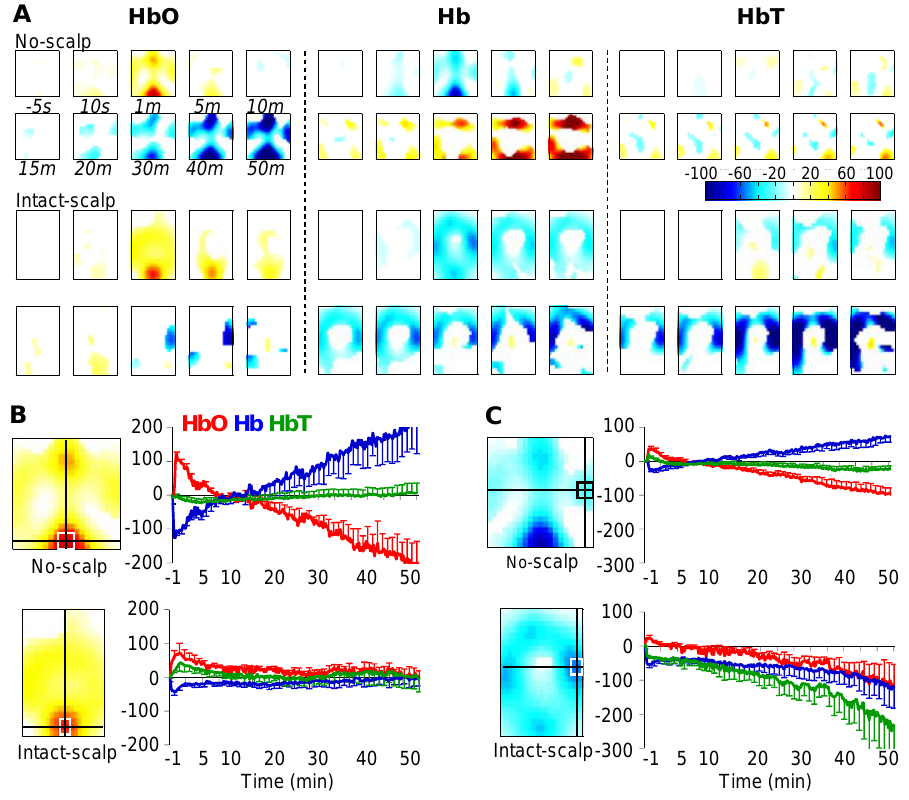
Figure 2. Formalin-induced hemodynamic changes in the no-scalp [12] and intact-scalp groups. ( A ) reconstructed images of hemodynamic changes at typical time points. The intensity of change (microMolar) is color-coded; only statistically significant changes (per pixel) are shown in color; ( B ) time series of hemodynamic changes at a middle posterior ROI (top: no-scalp [12]; bottom: intact-scalp). Locations of ROIs were determined in example images (left insets) at 1 min post injection in HbO; ( C ) time series of hemodynamic changes at a center ipsilateral ROI. Locations of ROIs were determined in example images (left insets) at 1 min post injection in Hb. In each image, top: rostral; bottom: caudal; right: ipsilateral; left: contralateral. Error bar: